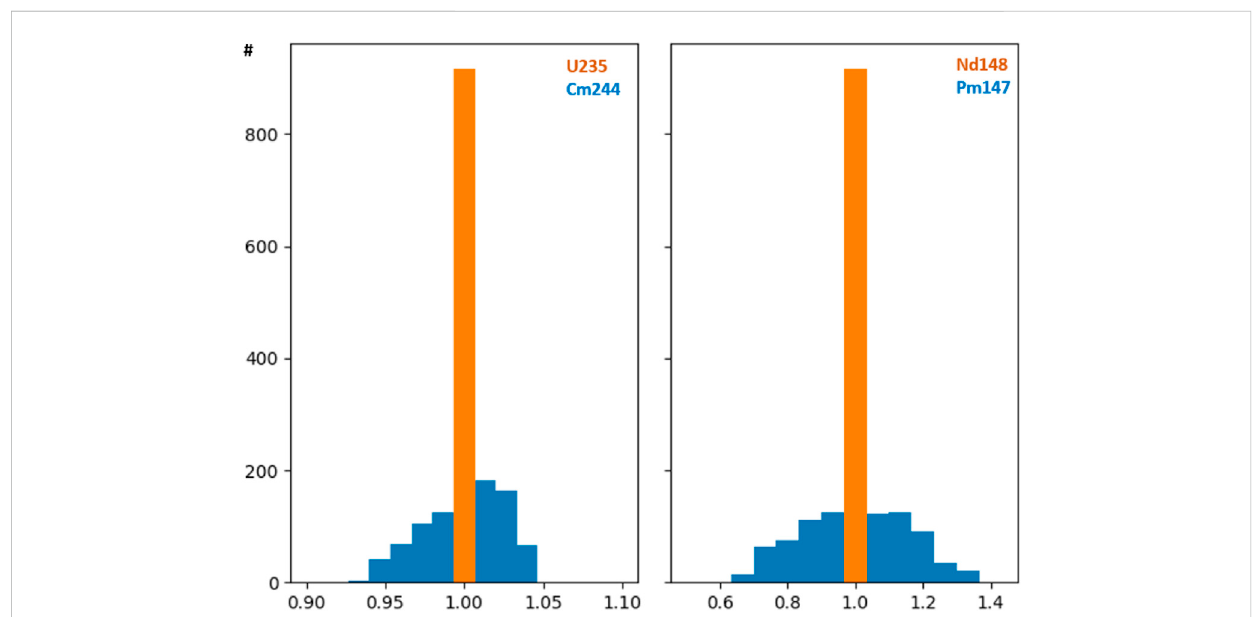
FIGURE 5 Concentration of 235 U, 244 Cm, 148 Nd, 147 Pm for a reference PWR UO2 assembly at 50MWd/kg; while the EOL burnup remained fi xed the power history and the cycle durations were randomly changed for the assembly ’ s 4-cycle